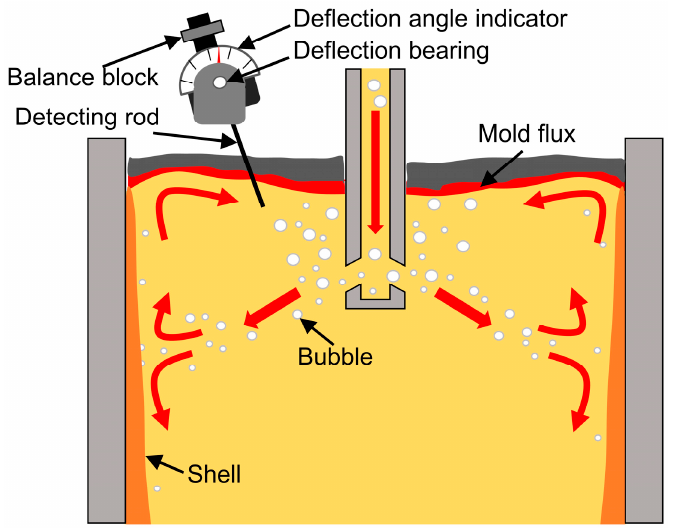
Figure 4. Schematic diagram of measuring velocity near the mold surface with the rod deflection method. Figure 5 is the comparison of the calculated and measured velocities of molten steel near the mold surface under the different argon flow rates in the EMBr Mode 3. The compared velocities are the values at the one-quarter width position of the thickness center slice of the mold. Under different argon flow rates, the calculated velocities on the mold surface are in good agreement with the measured values of the industrial experiment with the rod deflection method. With the increase in argon flow rate, both of the calculated and measured velocities first increase and then